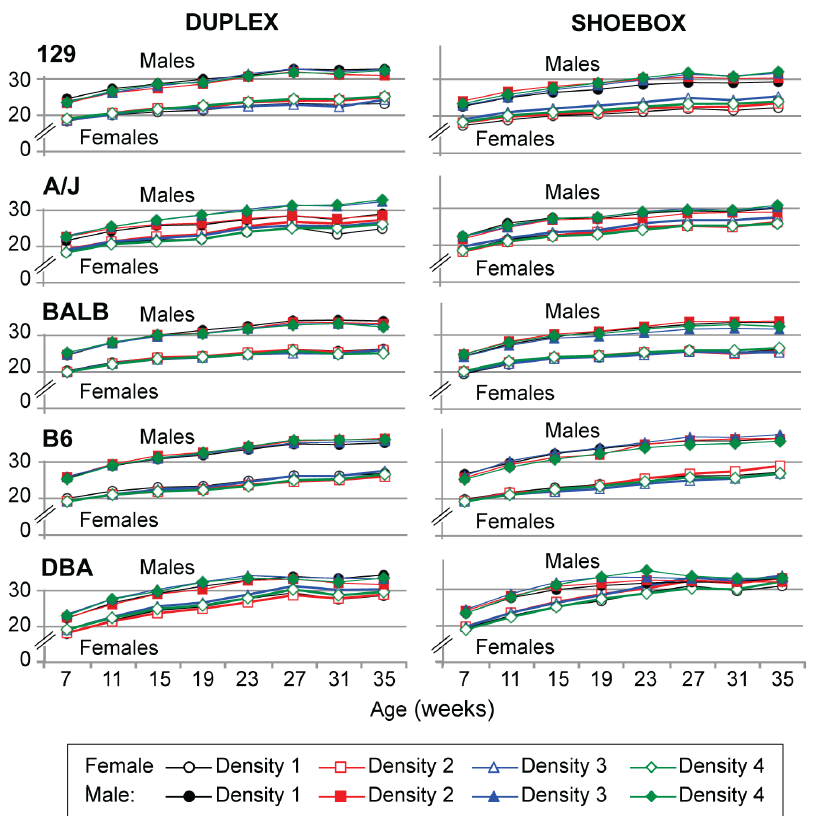
Figure 2. Body weight (g). N=16–18 animals per sex/strain. Standard errors are not shown because the maximum standard errors are within the size of the symbols.